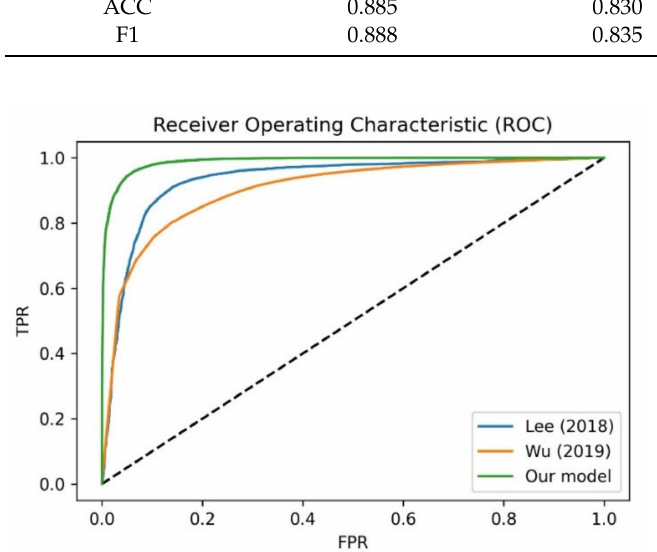
Figure 5. Receiver operating characteristic (ROC) of our model compared with Lee’s and Wu’s